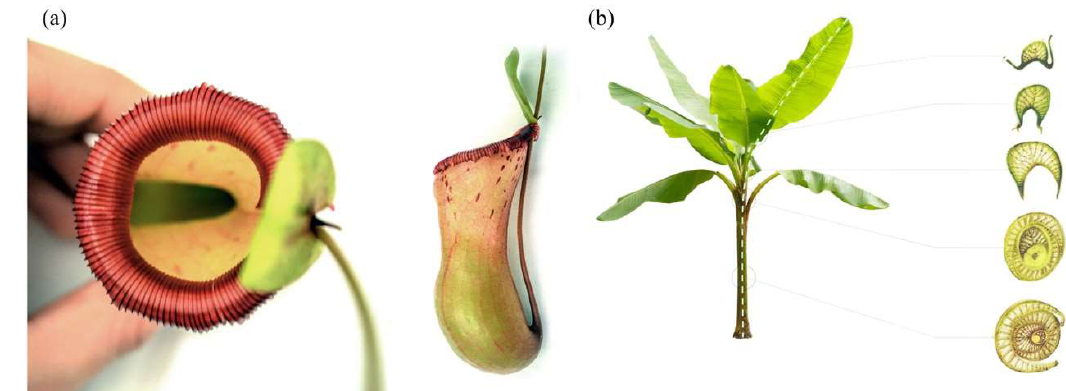
Figure 13. Morphological study of the Pitcher Plant ( a ) and bananas leaf stalks ( b ).